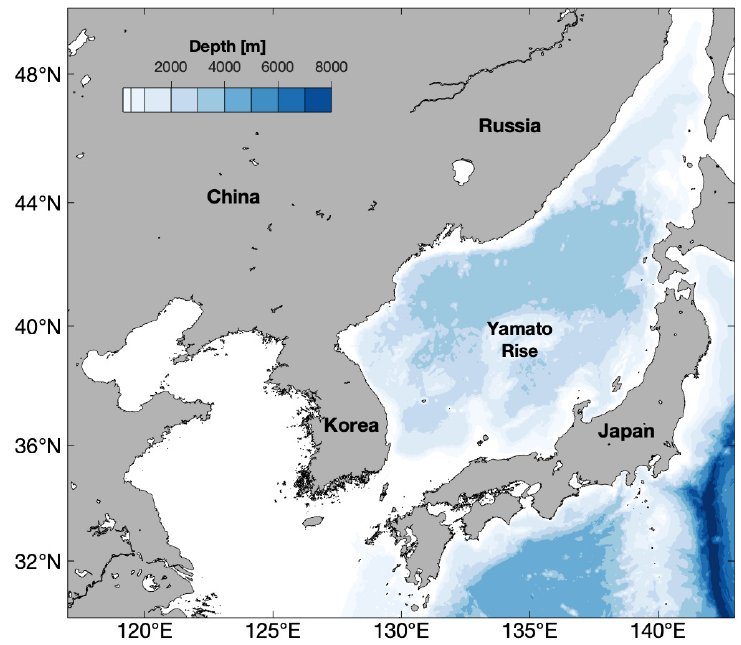
Figure 2. Numerical model domain and bathymetry used in numerical modeling. Table 1. Numerical modeling information.